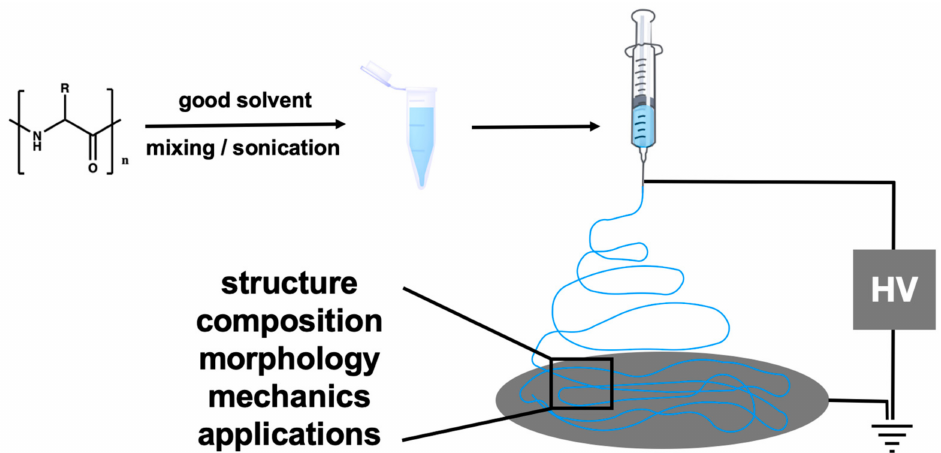
Figure 1. Schematic representation of peptide fiber formation via